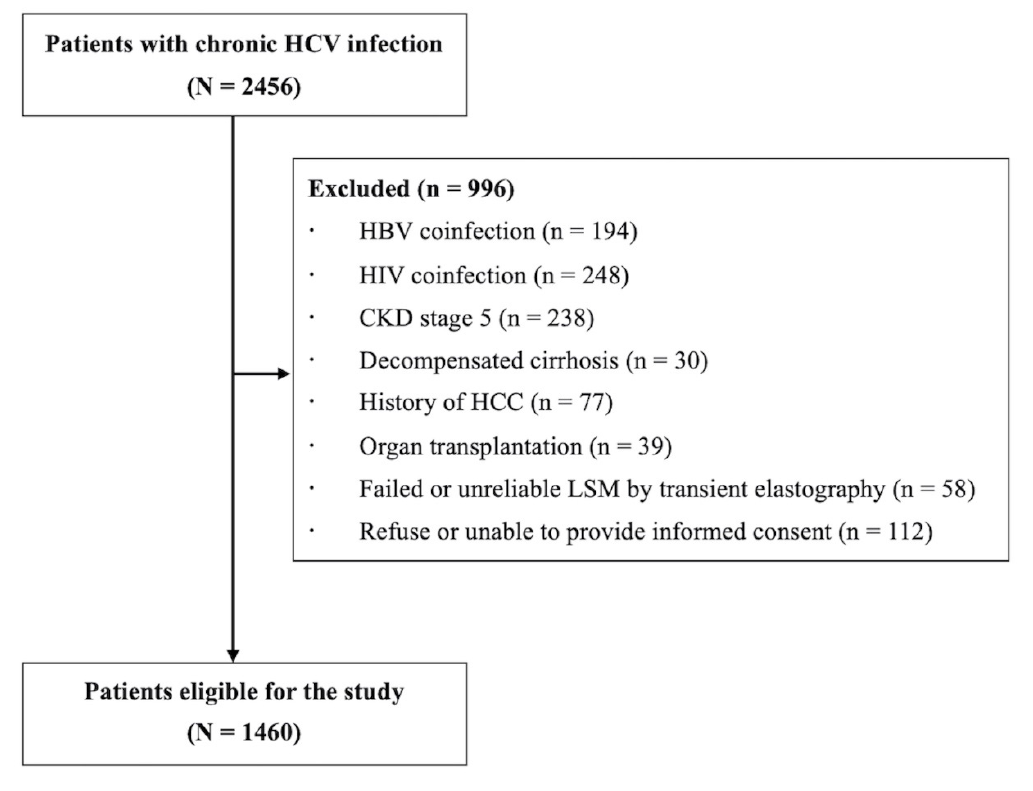
Figure 1. Study workflow.